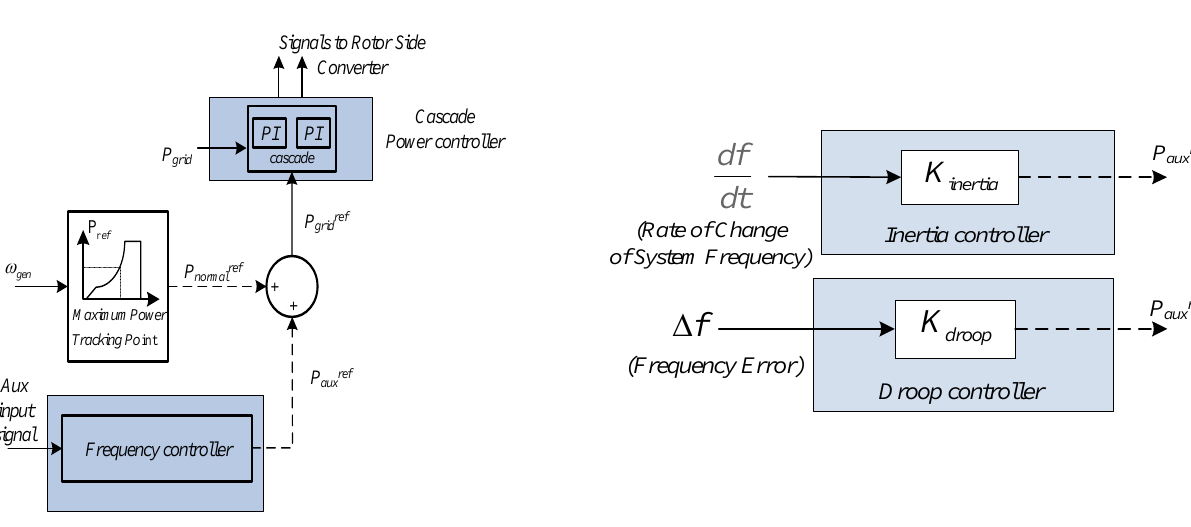
Figure 8. Frequency control scheme for the DFIG wind turbine configuration.